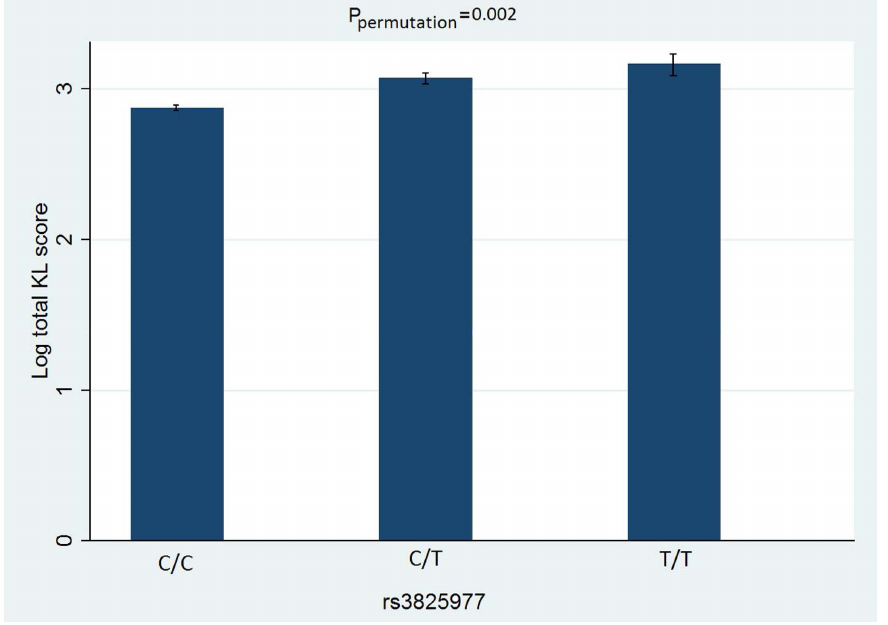
Figure 2. Total KL and each genotype of rs3825977. Error bars indicate Standard Error of the mean.